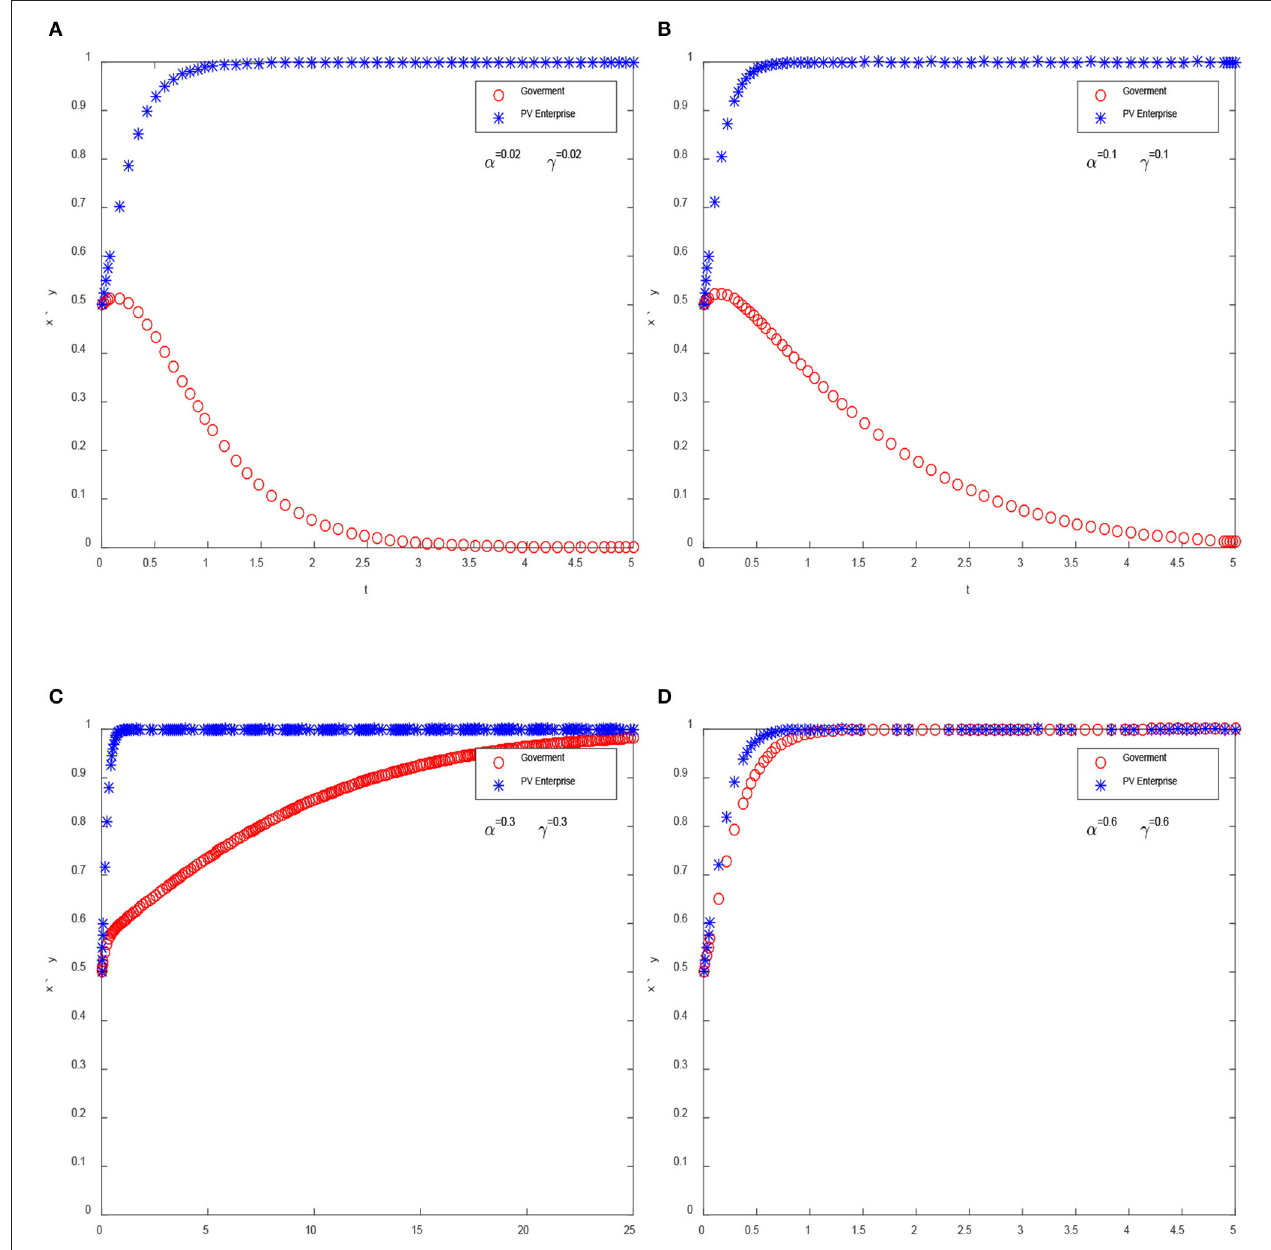
FIGURE 8 | The influence of α and γ on ESS. (A) α = 0.02 , γ = 0.02, (B) α = 0.1 , γ = 0.1, (C) α = 0.3, γ = 0.3, and (D) α = 0.6 , γ =